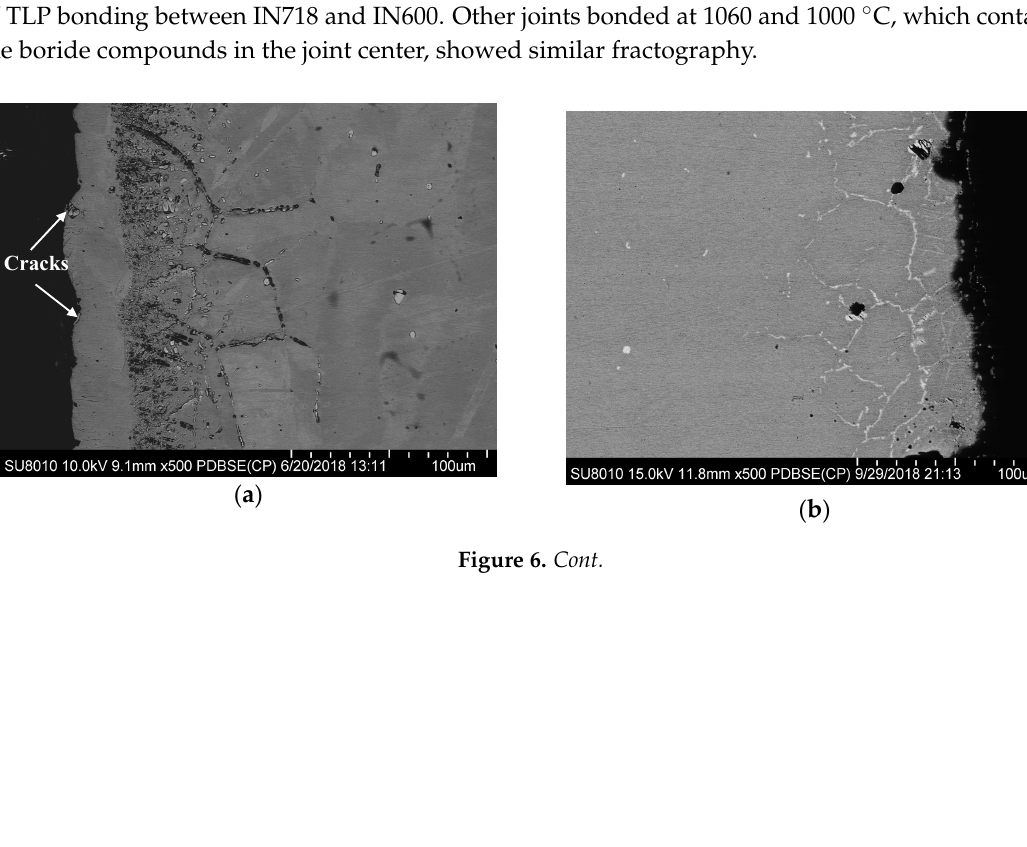
Figure 5. Effect of bonding temperature on the shear strength of TLP-bonded GH4169/BNi-2/GH4169 joints.